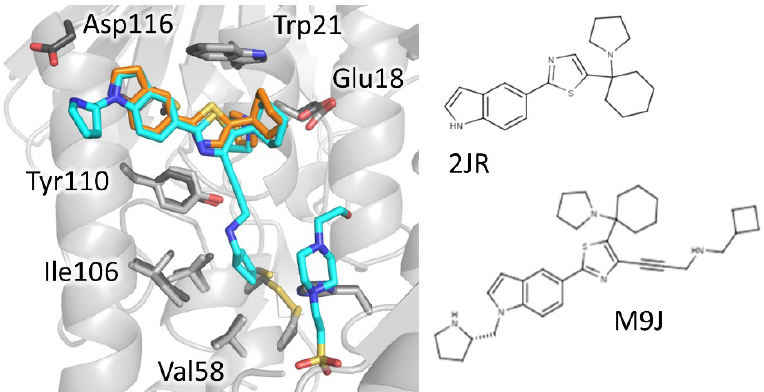
Figure 6 . Mode of binding of 1-(1-(benzo[b]thiophen-2-yl)cyclohexyl)piperidine (BTCP)-derivatives. Compound 2JR (orange) binds to MBS while its best performing evolution M9J (cyan) extends to the catalytic site and, in addition, a HEPES molecule binds deeper in the cavity (cyan). Critical residues are shown as sticks, light grey for inhibitor-free (PDB: 2wow) and dark grey inhibitor-bound TR (PDB: 6oez).